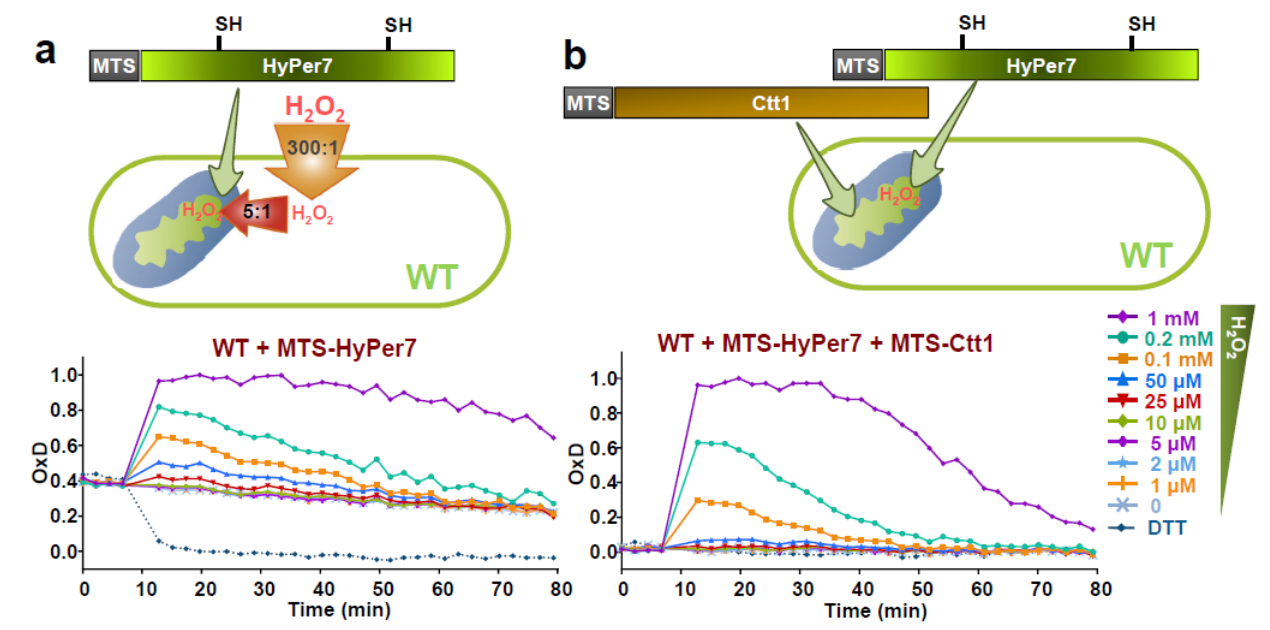
Figure 3. Mitochondrial MTS-HyPer7 is partially oxidized in basal conditions. ( a ) Strain HM123 (WT) transformed with plasmid p730 expressing MTS-HyPer7 targeted to the mitochondrial matrix was treated or not with H 2 O 2, and oxidation of the reporter was estimated as described in Figure 1. The gradients of extracellular-to-cytosol (300:1) and cytosol-to-matrix (5:1) upon addition of H 2 O 2 to the growing media are indicated. ( b ) Strain PN513 (WT) transformed with plasmids p730 and p790 expressing MTS-HyPer7 and MTS-Ctt1, respectively, in the mitochondrial matrix was treated and analyzed as in Figure 1. For each strain, average data from three biological replicates are shown, with error bars (S.D.) displayed in Figure S3.